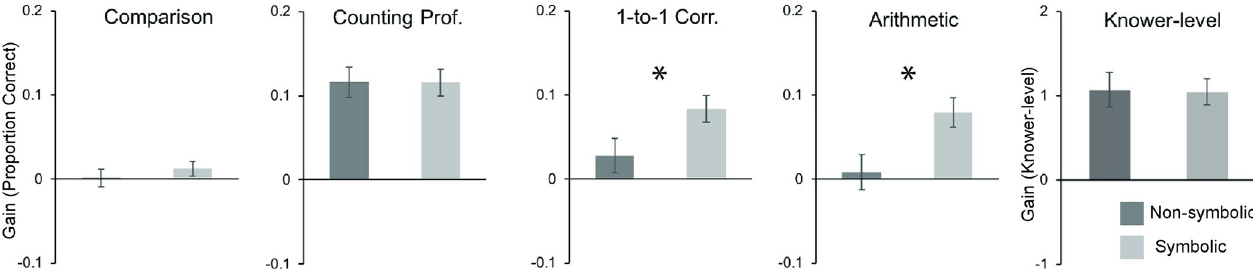
Fig 3. Mean gains in numeracy after numerical training with or without symbolic aids. Gains calculated as post-test score minus pre-test score. Error bars are -/+ 1 SE. � indicates statistically significant differences between numerical comparison training with and without symbolic number aids.